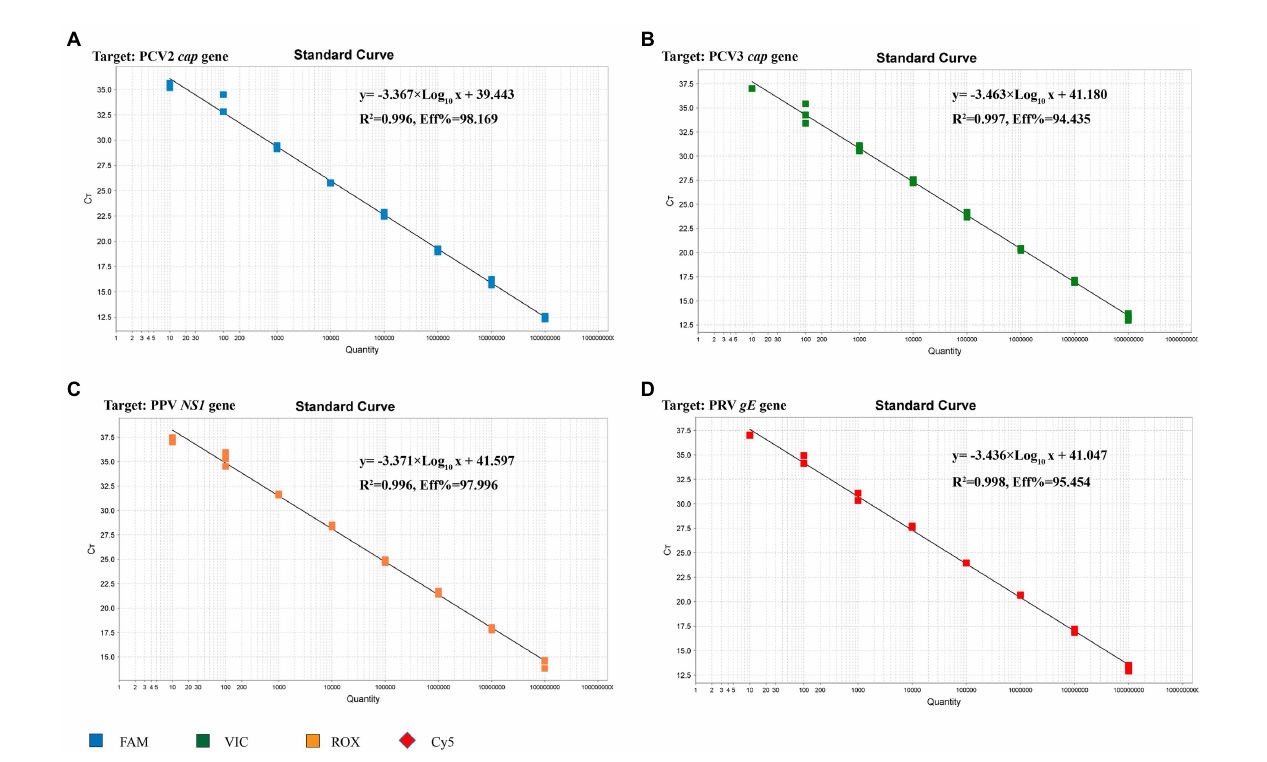
FIGURE 3 Standard curve for multiplex real-time PCR assay. (A) The standard curve for the PCV2 cap gene. (B) The standard curve for the PCV3 cap gene. (C) The standard curve for the PPV NS1 gene. (D) The standard curve for the PRV gE